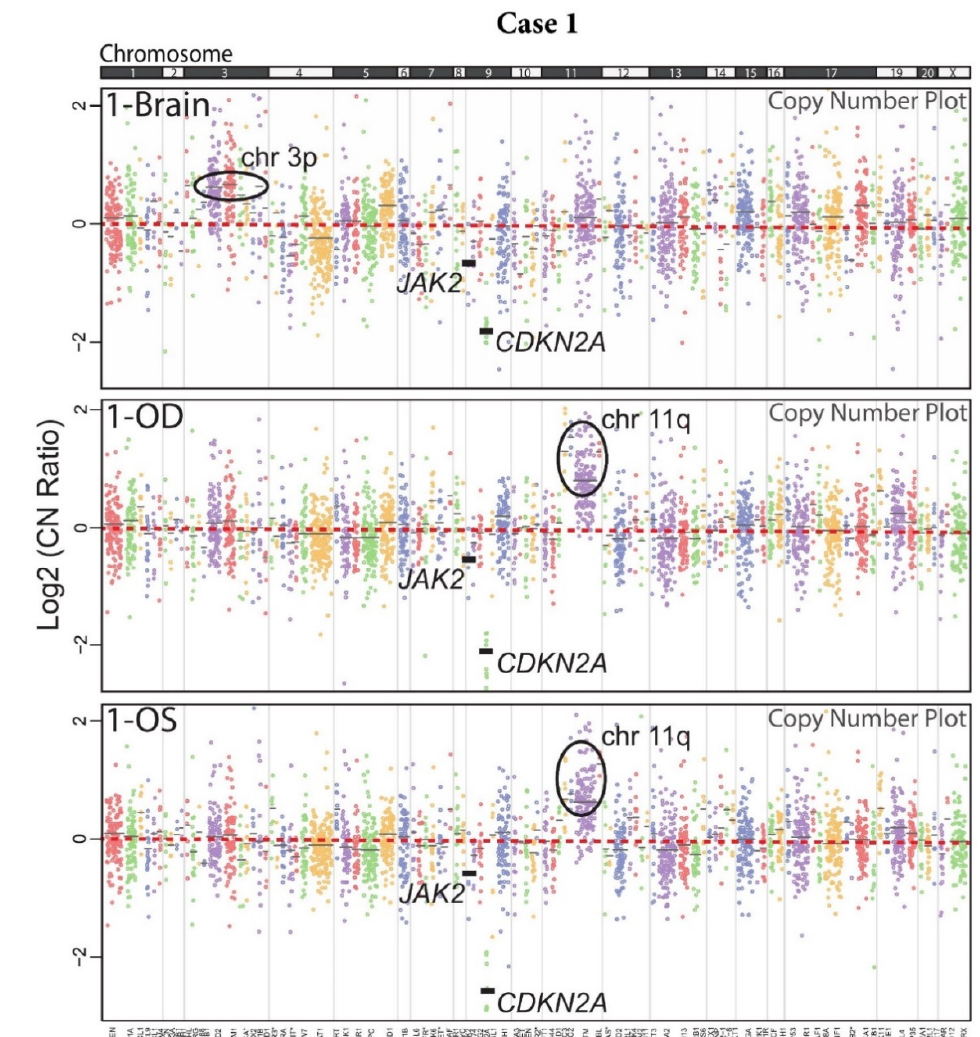
Figure 3. Copy number plots of matched brain tissue and vitreous liquid biopsy samples for Case 1. Copy number plots for each sample are shown as log2 copy number ratio (amplicon-level ratio between read counts in the tumor sample and read counts in a composite of normal samples, normalized for sequencing depth and GC content). Dots represent individual amplicon log 2 copy number ratios. Dots of the same color represent a gene, and black horizontal bars represent average gene-level log2 copy number ratio estimates (coverage-weighted). Genes are listed at the bottom in chromosome order, and chromosomes are separated by gray lines and marked at the top. Genes marked with * have two groups of amplicons with different colors covering them. Altered/relevant genes are highlighted with thick, black gene-level log2 copy number ratio lines. Altered, broad genomic regions are marked with black ovals.